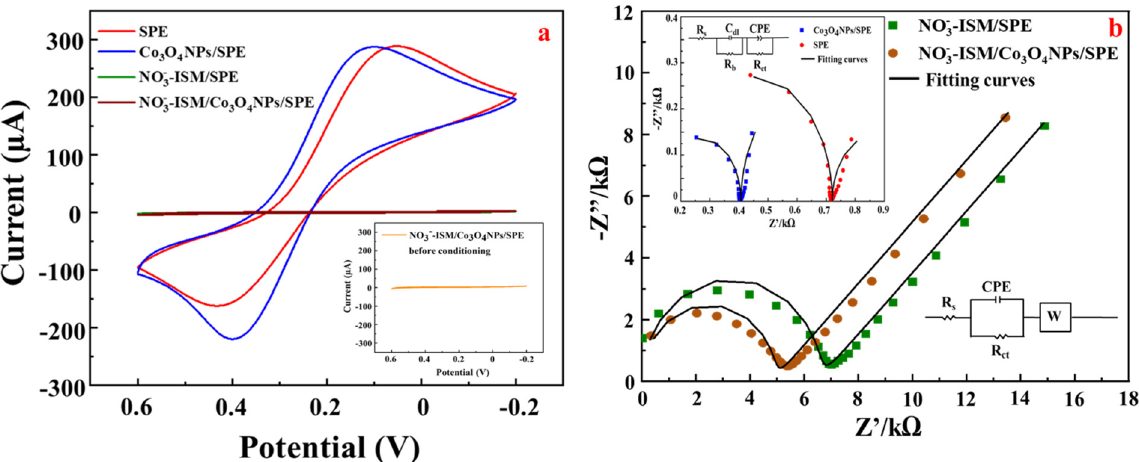
Figure 6. ( a ) CV curves for SPE (red line), Co 3 O 4 NPs/SPE (blue line), NO 3 − -ISM/SPE (green line), NO 3 − -ISM/Co 3 O 4 NPs/SPE with conditioning (brown line), and NO 3 − -ISM/Co 3 O 4 NPs/SPE without conditioning (inset). ( b ) Nyquist plots for SPE (red points), Co 3 O 4 NPs/SPE (blue points), NO 3 − -ISM/SPE (green points), and NO 3 − -ISM/Co 3 O 4 NPs/SPE (brown points) and their corresponding electrochemical impedance spectra fitting curves (black line).